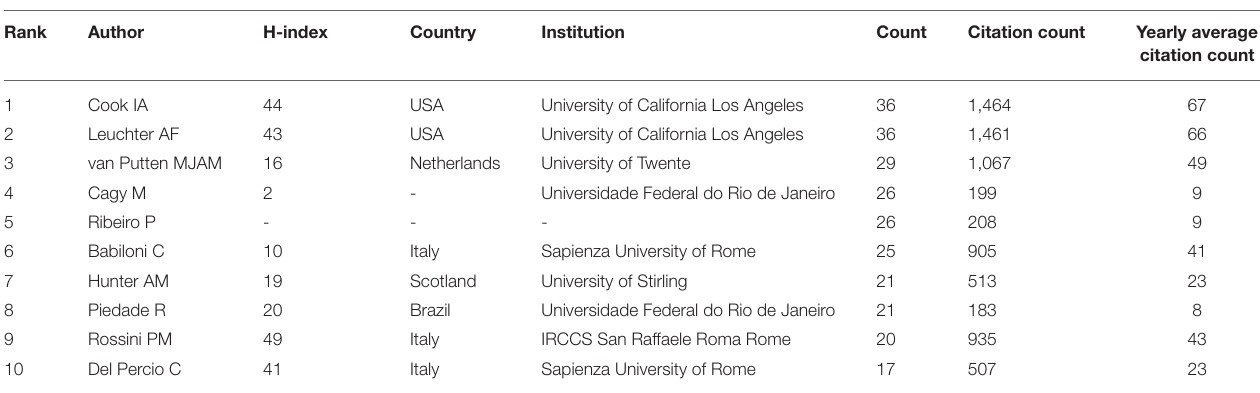
TABLE 2 | Top 10 productive authors from 2000 to